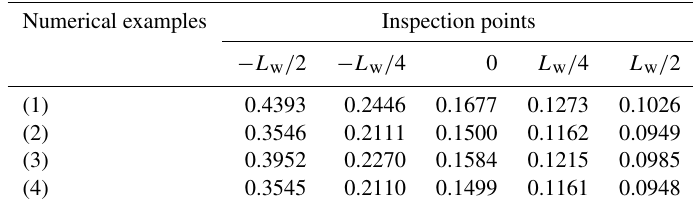
Table 4. Values of k ML at the inspection points on the e flank of the conical worm.